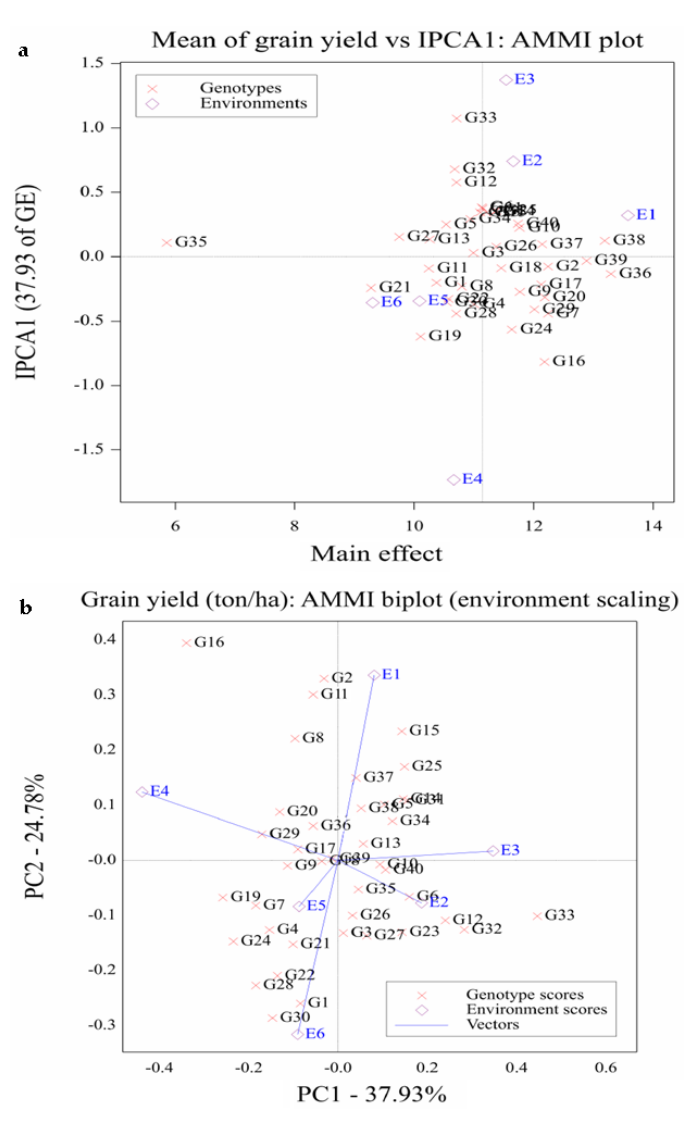
Figure 2. AMMI1 ( a ) and AMMI2 ( b ) biplots for grain yield of 40 developed maize hybrids and 4 commercial checks (assessed as G1–G40) evaluated in six agro-environments (coded as E1–E6).